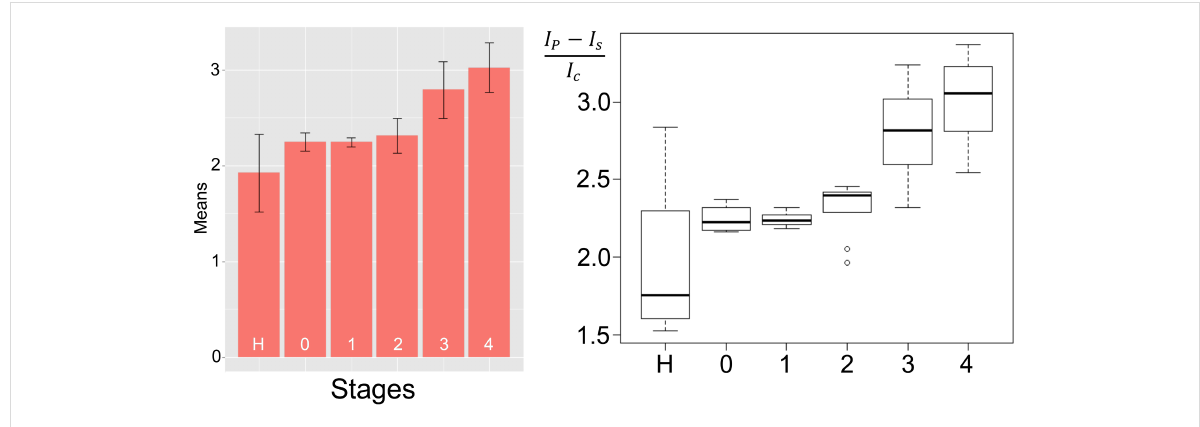
Figure 7: Bar graph (left, showing means and standard deviations) and box plot (right, indicating the observed data range) for cathepsin L. The group sizes are H (apparently healthy control group, n = 20), 0: breast cancer stage 0 ( n = 4), 1: breast cancer stage 1 ( n = 9), 2: breast cancer stage 2 ( n = 9), 3: breast cancer stage 3 ( n = 12); 4: breast cancer stage 4 ( n = 12). All biospecimens were obtained from the South Eastern Nebraska Cancer Center (SNCC). Breast cancer has been staged according to the TNM staging system [25].